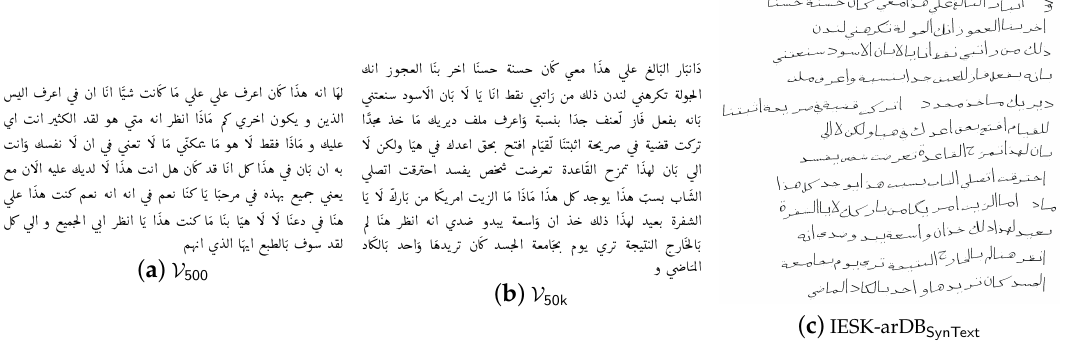
Figure 5. Examples for Arabic pseudo text, which is Unicode text generated by linking words of a vocabulary . ( a ) 500 different, ( b ) 50,000 most common Arabic words are used. ( c ) A text image, that V was synthesized from a pseudo text page